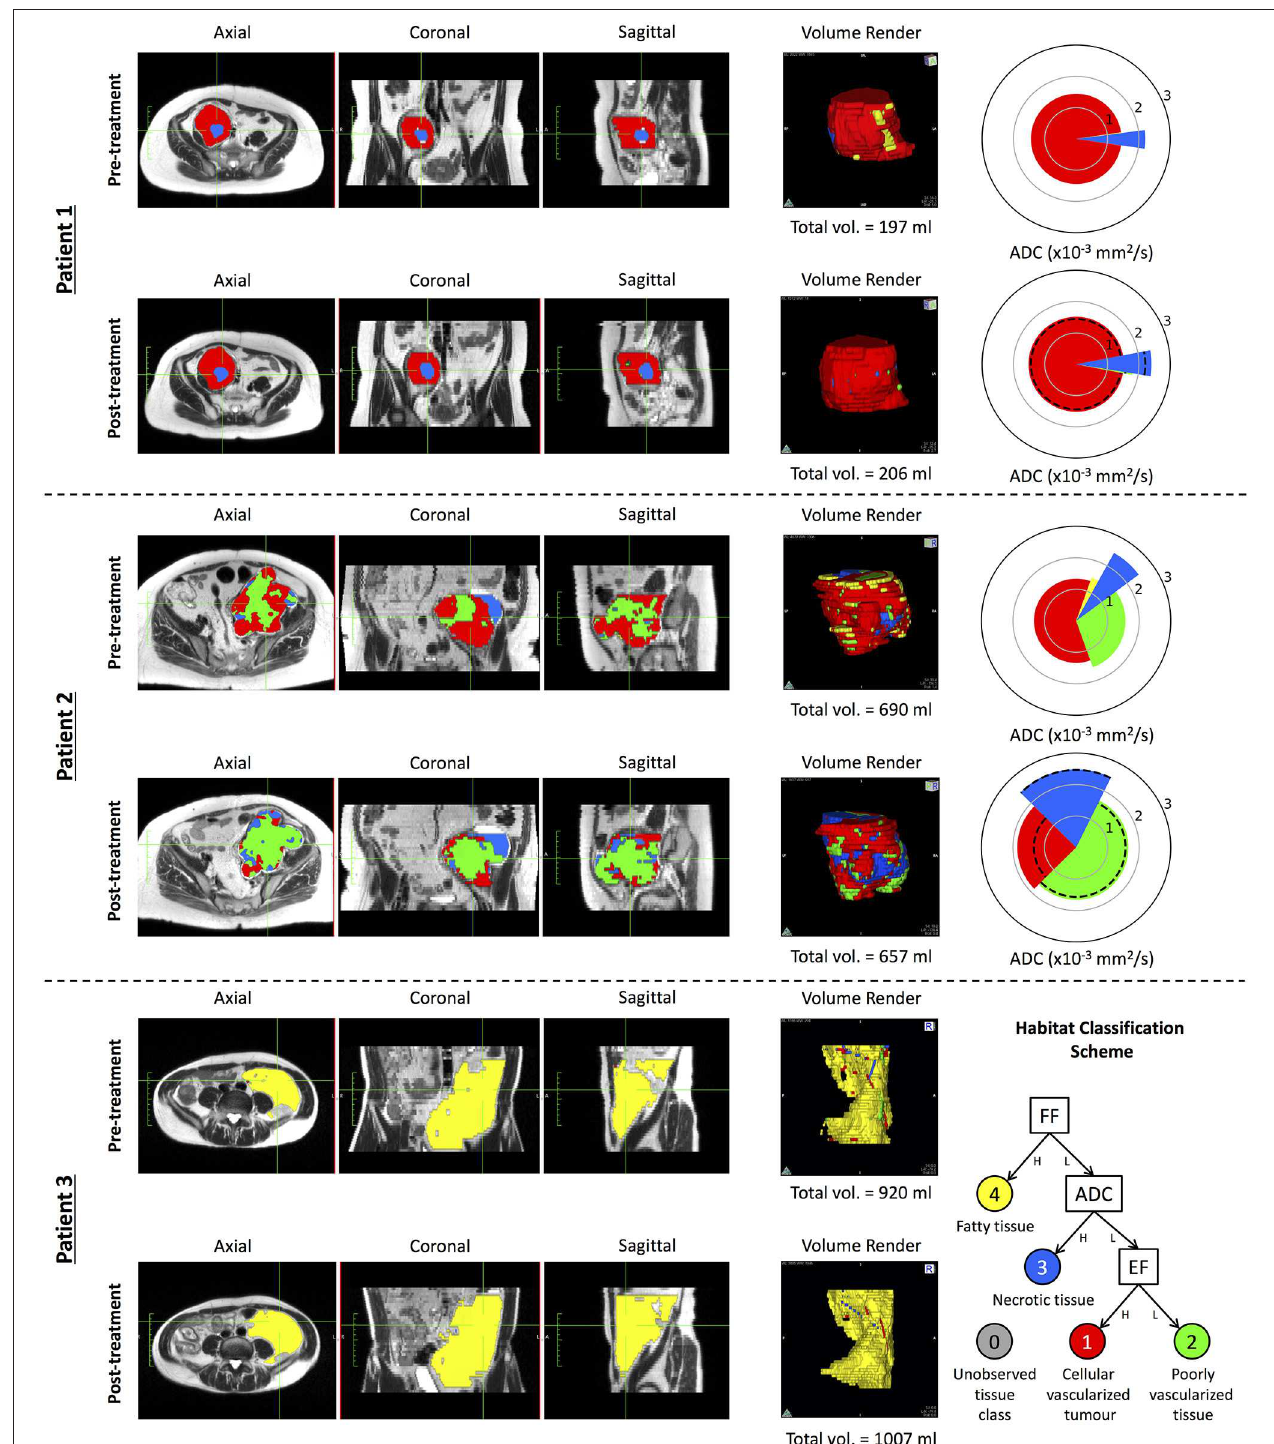
FIGURE 5 | A demonstration of our proposed habitat classification scheme on three patients applied before and after radiation therapy. Spie charts are presented with a radius equal to the mean ADC of the given tissue sub-compartment; dotted lines on the post-treatment Spie charts show the ADC of that tissue sub-type in the pre-treatment data. Multi-planar reformat habitat maps are overlain on T2 HASTE MR-images acquired within the same patient study. Patient 1 demonstrates a patient with a liposarcoma where a necrotic core is clearly identified (blue) within a majority of strongly enhancing solid tumor (red) prior to treatment. Although thereisamarginalincreaseinthevolumeofthenecroticcore,therelittleoverallchangeisobservedfollowingtreatment. Patient2 demonstratesdatafromapleomorphic